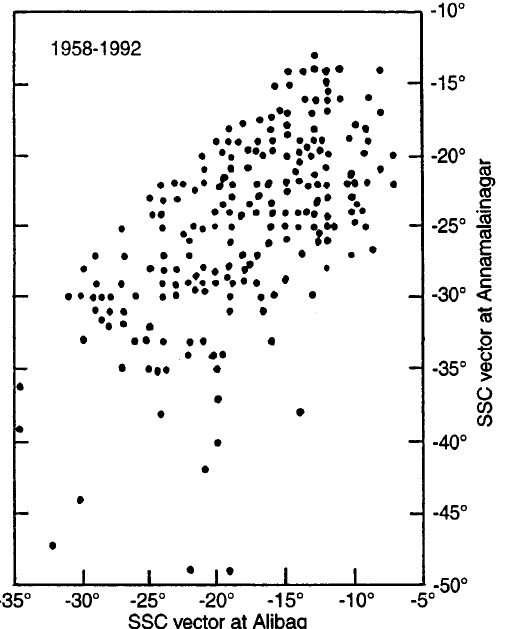
Fig. 11. Mass plot of the direction of SSC disturbance vector at Annamalainagar versus that at Alibag for 1958–1992